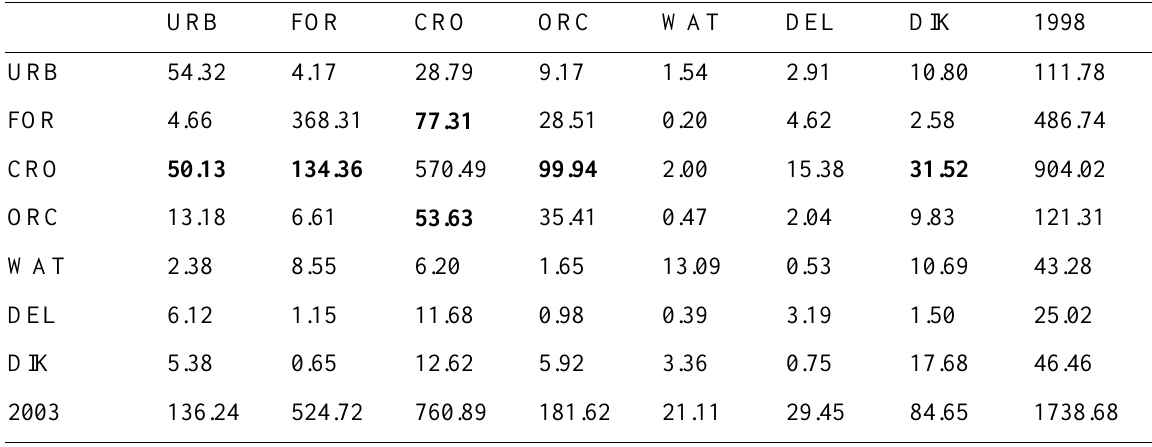
Table 6. Land use change matrix in Panyu from1998 to 2003 (km 2 ). URB FOR CRO ORC WAT URB FOR CRO ORC